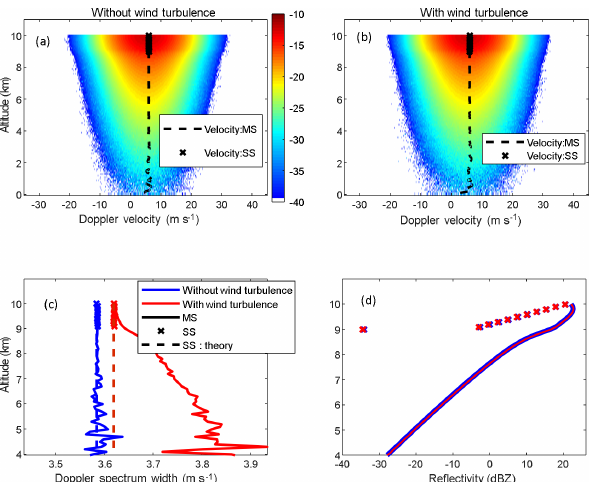
Figure 4. Estimated Doppler spectrum moments for a Doppler CPR/EarthCARE-like radar. (a) Doppler spectrum without wind turbulence. Doppler velocity profiles are superimposed (MS: dot- ted line, SS: cross). (b) Same as (a) , but with wind turbulence. (c) Vertical profiles of MS (full lines) and SS (crosses) Doppler spectrum width with wind turbulence (red) and without wind turbu- lence (blue). (d) Vertical profiles of MS (full lines) and SS (crosses) reflectivity with wind turbulence (red) and without wind turbulence (blue). The altitude of the base of the iced homogeneous cloud layer (optical depth of 3) is 9km. Its geometrical thickness is